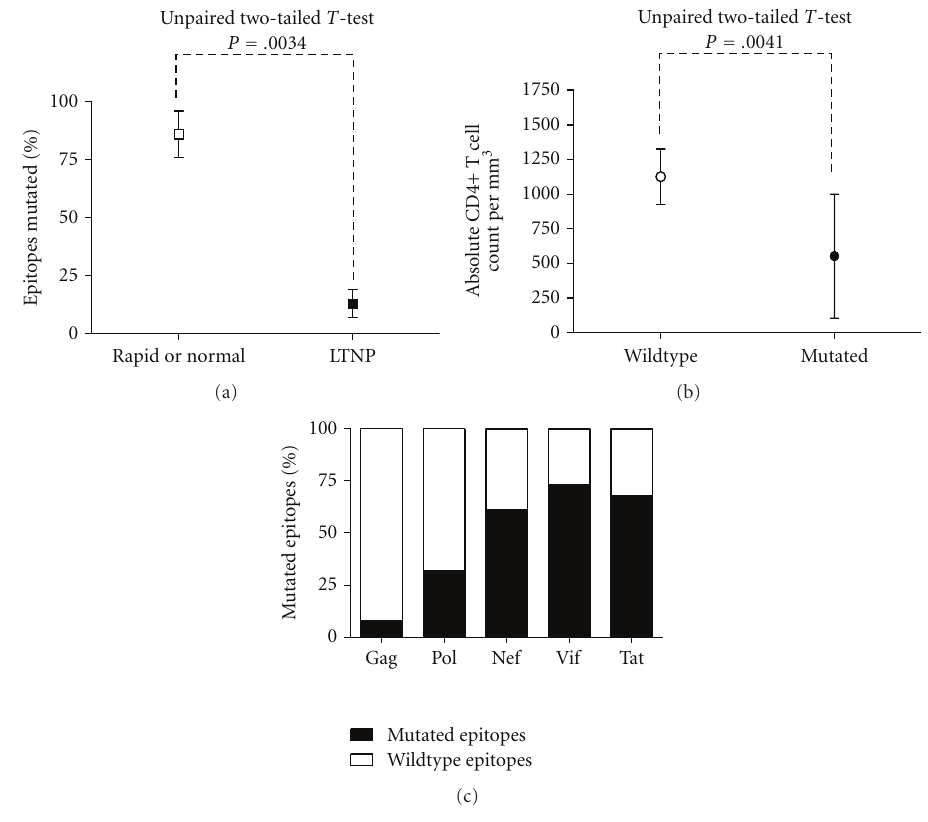
Figure 3: Viral Evolution and Disease Progression. (a) Sequencing was performed for all recognized CTL epitopes in the ELISPOT assay (3–5 clones per epitope and 2–3 epitopes per animal) for each animal (6 animals) at all time points that the animal was virus positive (2–5 per animal) ( n = 24–72 clones per analysis). Accumulated mutations were noted and the percent of epitopes that showed mutations (regardless of the e ff ect of the mutation on CTL responses) were compared between the NP/RP and SP/LTNP groups. (b) CD4 T cell absolute counts were measured at every time-point in which ELISPOT assays were performed and these counts were compared between animals carrying virus with wild-type epitopes or mutated epitopes. (c) Comparison of the number of accumulated mutations observed in CTL epitopes in viral proteins. Statistical analysis was performed using unpaired two-tail t